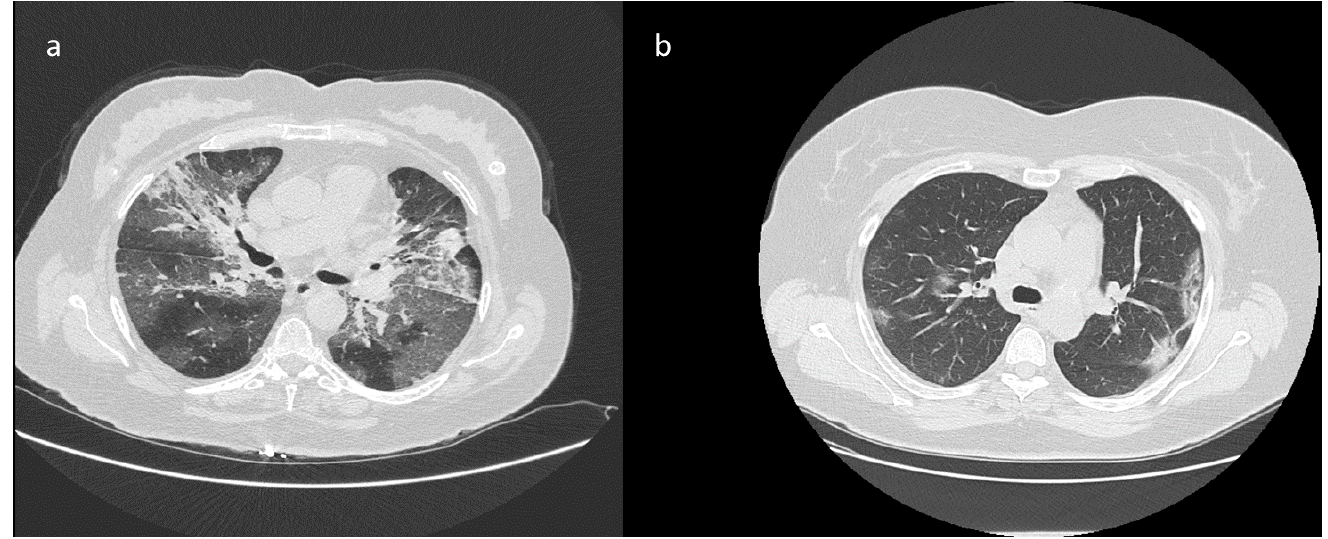
Figure 3. Patients with a positive RT-PCR test for COVID-19 infection. The CT exams detected areas of GGO and parenchymal consolidation with multifocal diffuse ( a ) or predominantly peripheral distribution ( b ).